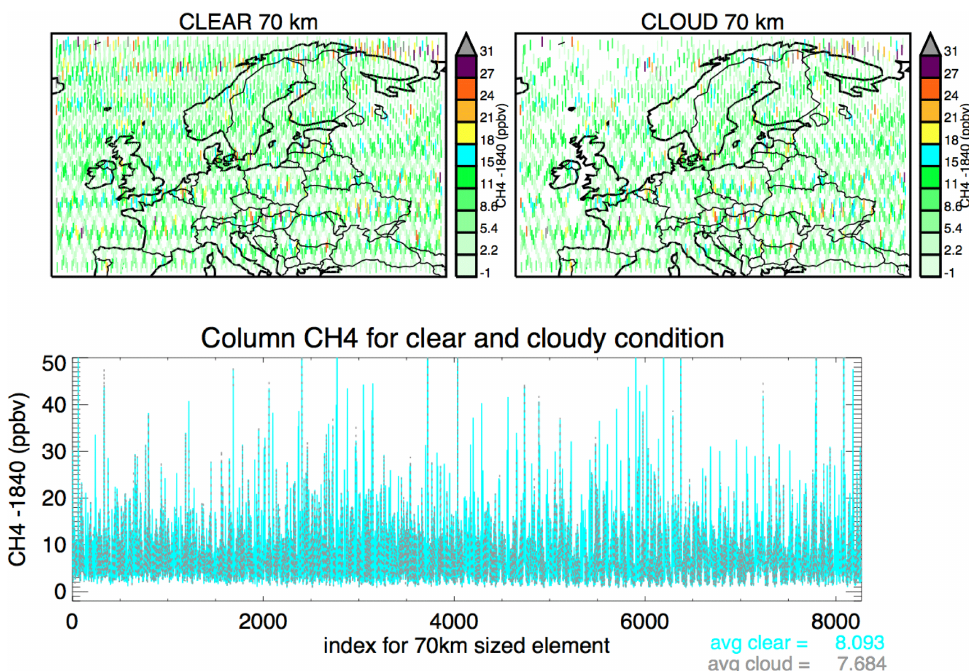
Fig. 8. (a) Simulated total column CH 4 values observed by a proposed laser instrument averaged to a 70km spatial resolution, assuming clear sky conditions. (b) Same as (a) but rejecting CH 4 values co-located with CALIPSO-observed cloud optical depths greater than 0.5. (c) Same as (a) and (b) except plotted by sample number